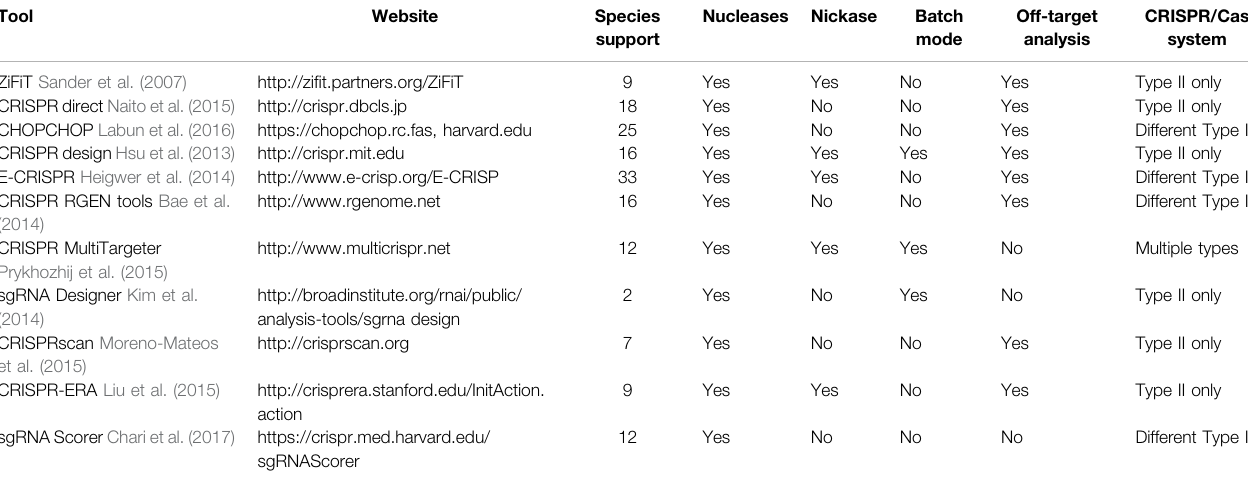
TABLE 3 | A summary of the most applicable tools to design sgRNA.